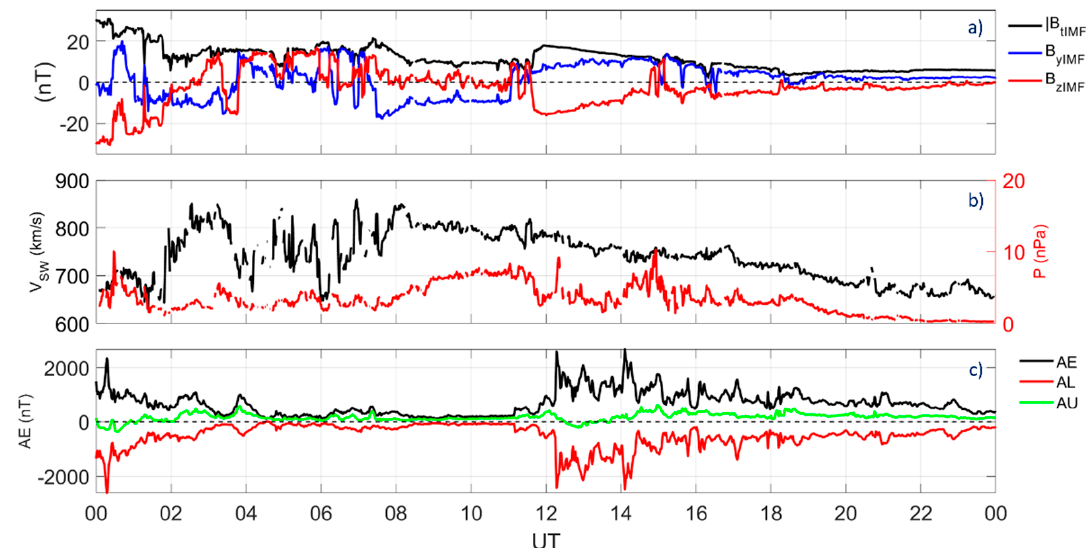
Figure 1. Interplanetary space observations and geomagnetic response at high latitudes on 8 September 2017. From top to bottom: ( a ) Interplanetary Magnetic Field (IMF) intensity (black), IMF B y,IMF component (blue) and IMF B z,IMF component (red); ( b ) solar wind (SW) velocity V SW (black) and SW dynamic pressure P (red); and ( c ) AE (black), AU (green) and the AL (red) indices. IMF and SW data are taken from the OMNI database.